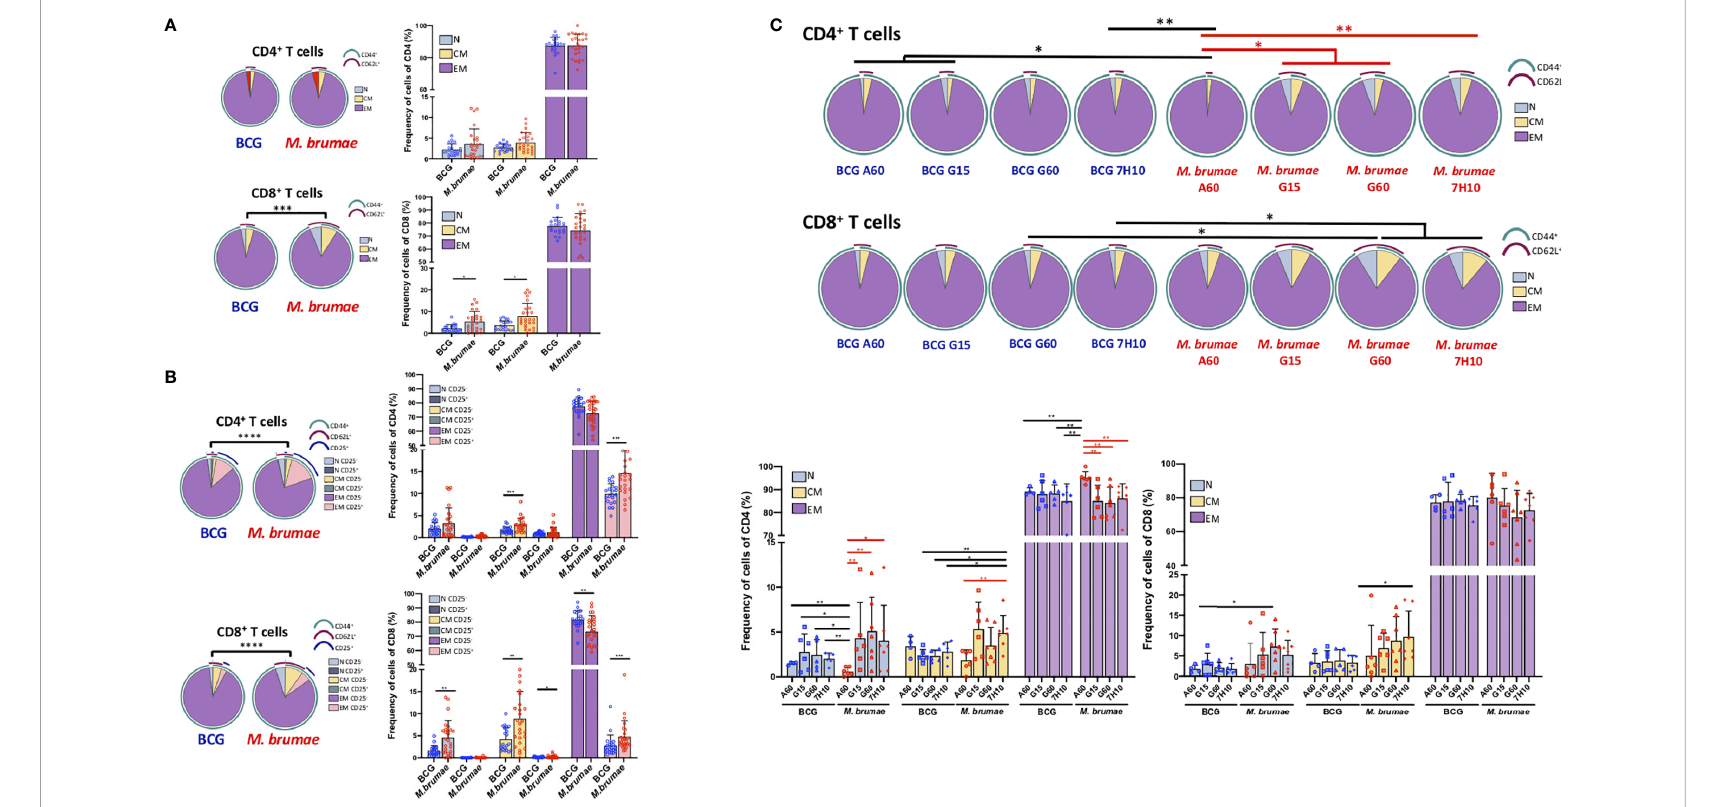
FIGURE 4 CD4 + and CD8 + T -cell maturation pro fi les of bladder in fi ltrating cells differ after different mycobacteria treatments. Immune maturation pro fi le in BCG- and M. brumae -treated mice in (A) CD4 + and CD8 + T- cells and in (B) CD4 + and CD8 + T-cells expressing CD25. The differential marker expression was analyzed by boolean gating. (C) CD4 + and CD8 + T-cell maturation pro fi le in bladder tumors from mice treated with BCG and M. brumae cultured in different media. Pie charts illustrate relative proportions of each of the different subsets in the different group of animals. Arcs show population makeup and overlap within pie slice. Statistical analyses of the global maturation pro fi les were performed by partial permutation tests using the SPICE software (*p < 0.05, **p < 0.01, ***p < 0.001****p < 0.0001). Bar graphs indicate percentages of the different populations within CD4 + or CD8 + T-cells. Data represent the mean (bars) and ± SEM (error bars) and each dot represent an individual mouse treated with BCG (blue dots) or M. brumae (red dots). Statistically signi fi cant differences between the different M. brumae mycobacteria are shown as red lines. Interstrain differences are shown in black. Differences were tested using Mann-Whitney U nonparametric test. *p ≤ 0.05; **p ≤ 0.01; ***p ≤ 0.001. N: naïve cells (CD62L + CD44 - ); CM: central memory cells (CD62L + CD44 + ) and EM: effector memory cells (CD62L - CD44 +